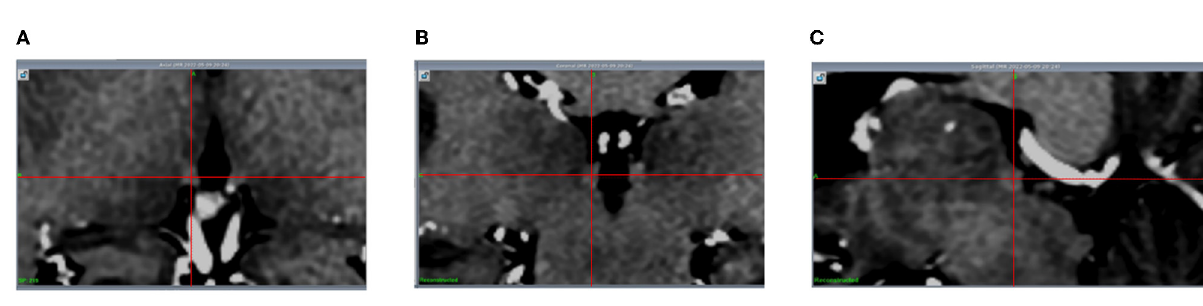
patient. Computed tomography (CT) was performed and the results fused with those of the pre-surgical MRI. According to the locations of the left and right LHb in each patient, a safe frontal trajectory was planned for the left LHb and right LHb of each